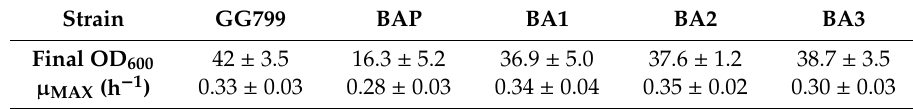
Table 2. Final OD 600 and Growth Rate µ MAX (h − 1 ) of all strains constructed in this study. The strains were grown in Shake Flasks. Values were obtained from biological